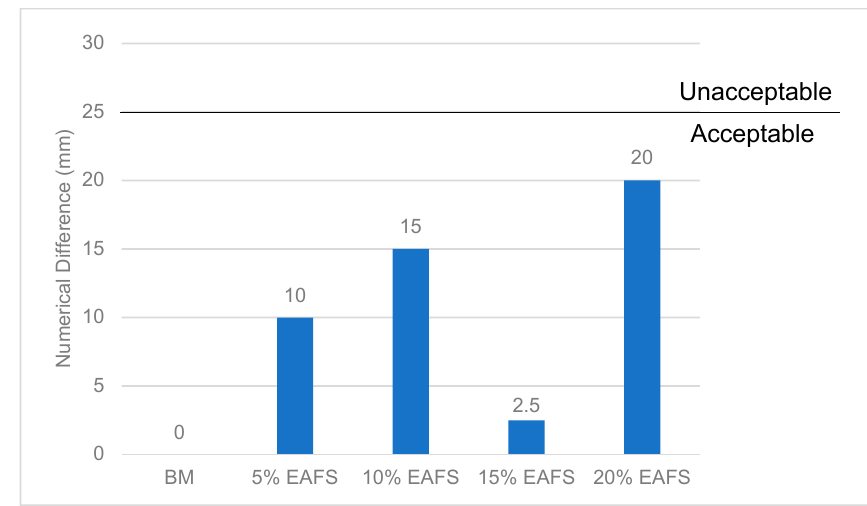
Figure 12. Numerical difference of the J-Ring flow and slump flow for SCC samples containing varying doses of EAFS.